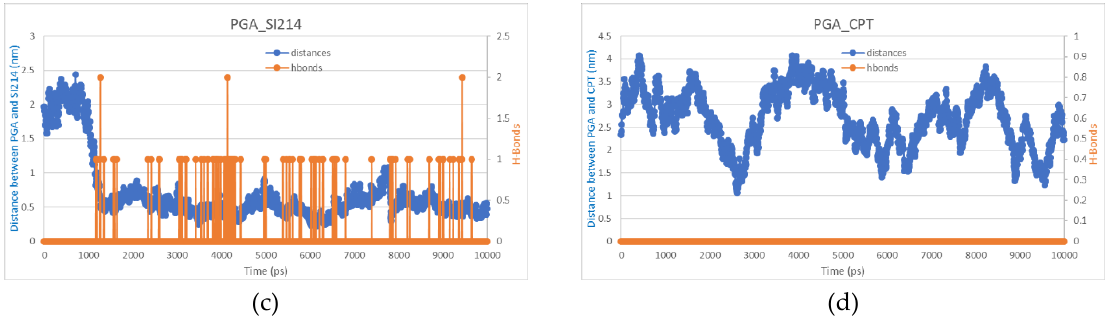
Figure 2. ( a ) The final configuration of the PGA dimer (grey) and the SI214 molecule (green) after a 10 ns all atom Molecular Dynamics simulation; ( b ) distance (blue) and H-bonds (orange) between PGA and SI214; ( c ) the final configuration of the PGA dimer (grey) and the CPT molecule (green) after a 10 ns all atom Molecular Dynamics simulation; ( d ) distance (blue) and H-bonds (orange) between PGA and CPT.